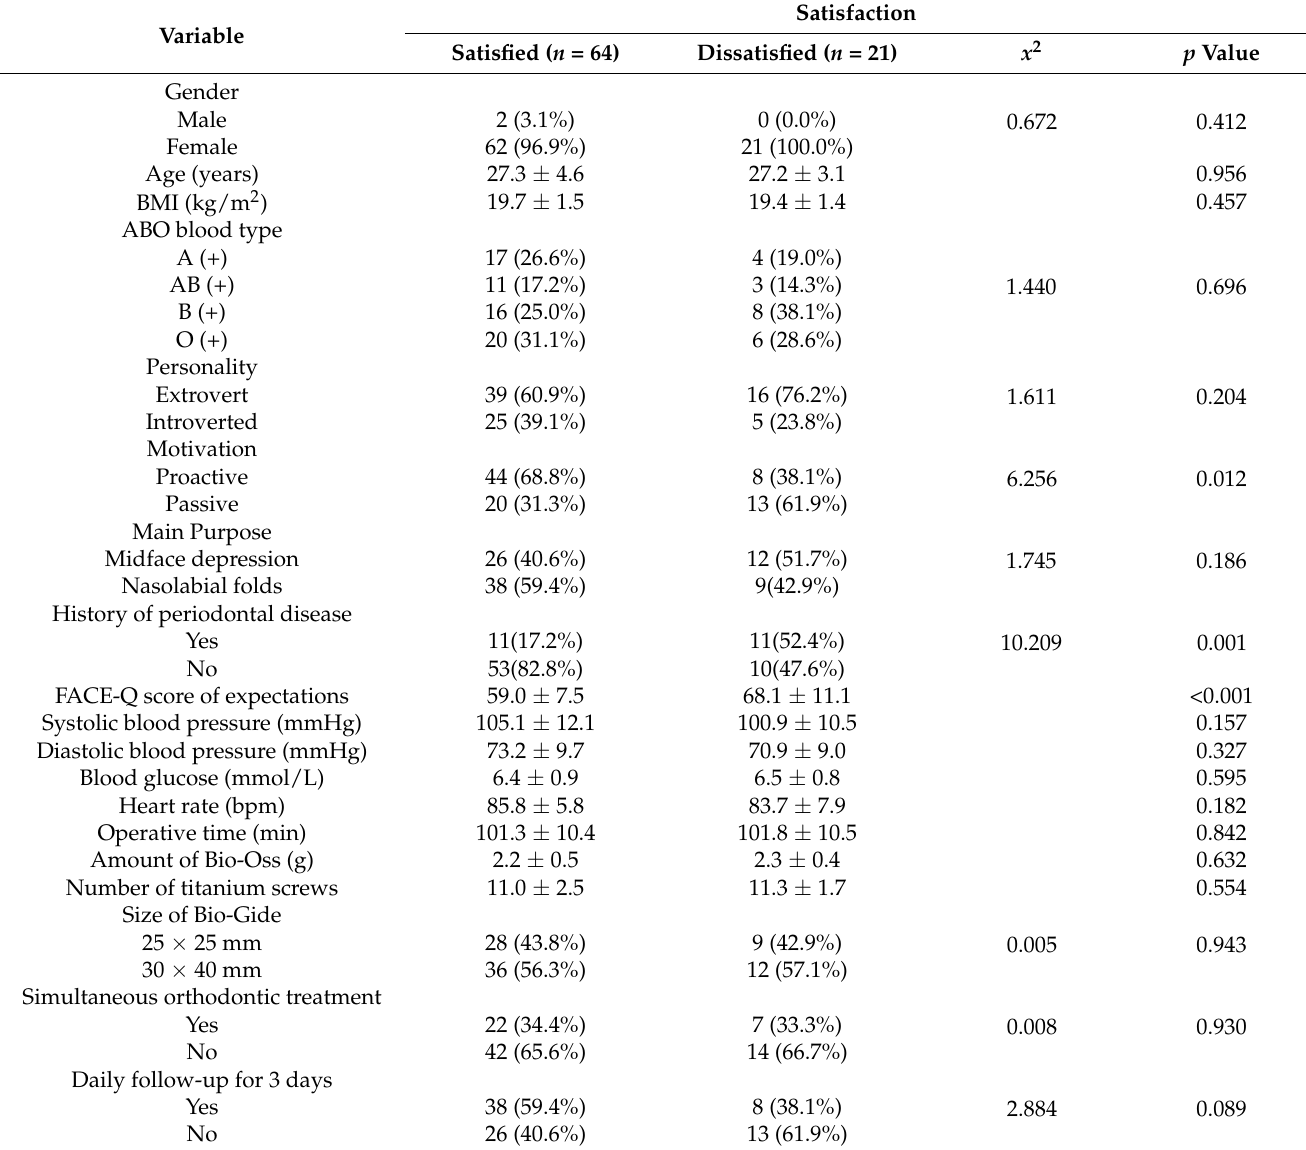
Table 4. Factors affecting patient satisfaction after midface augmentation (with t -test and x 2 test) a .